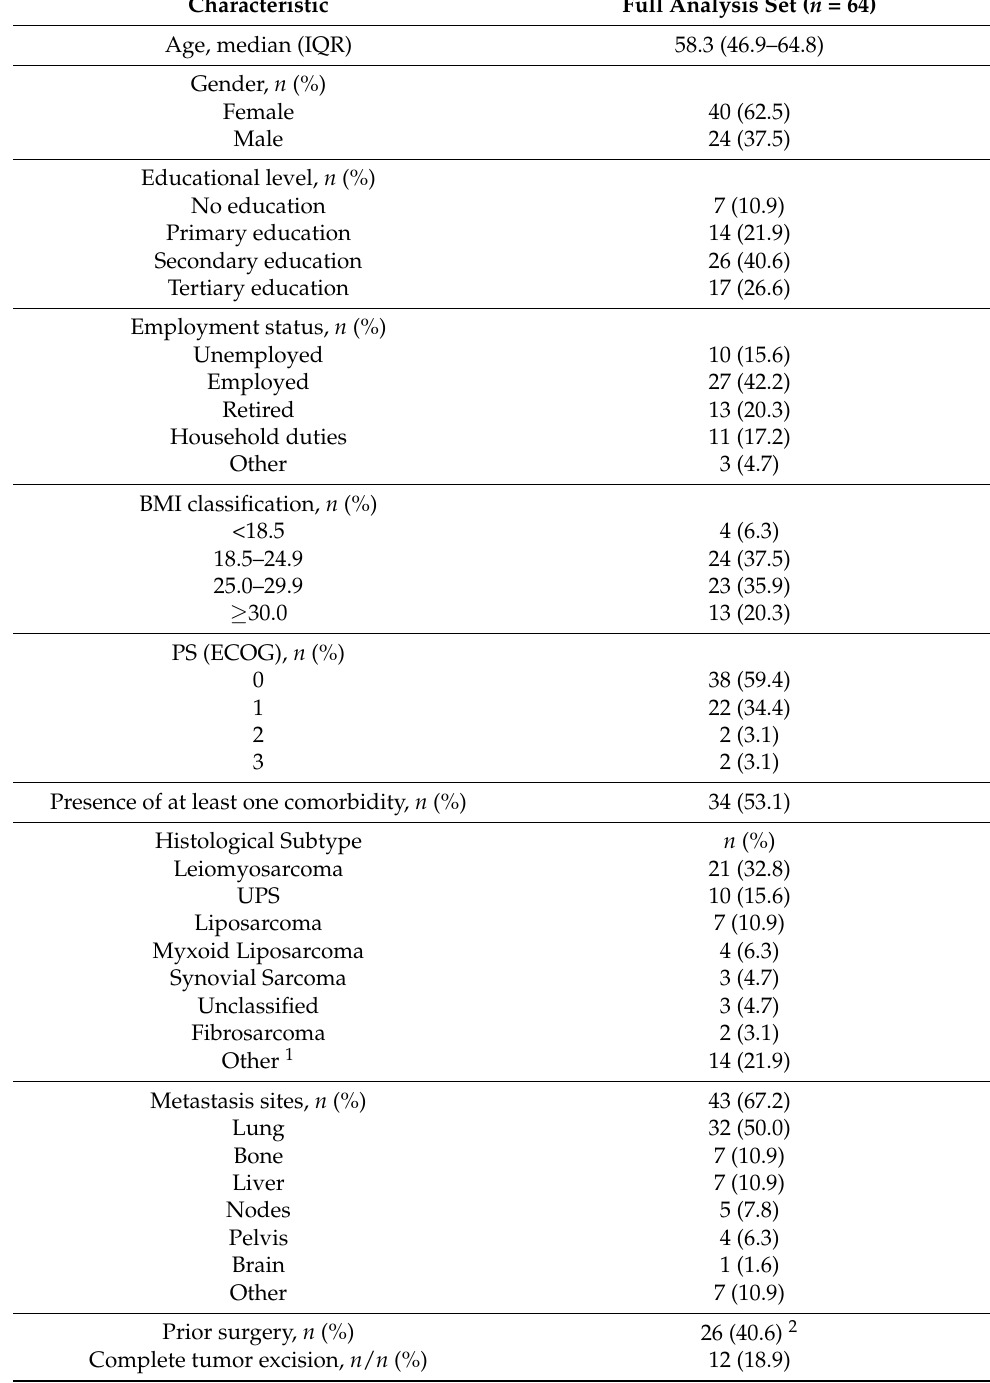
Table 1. Patient and disease characteristics at